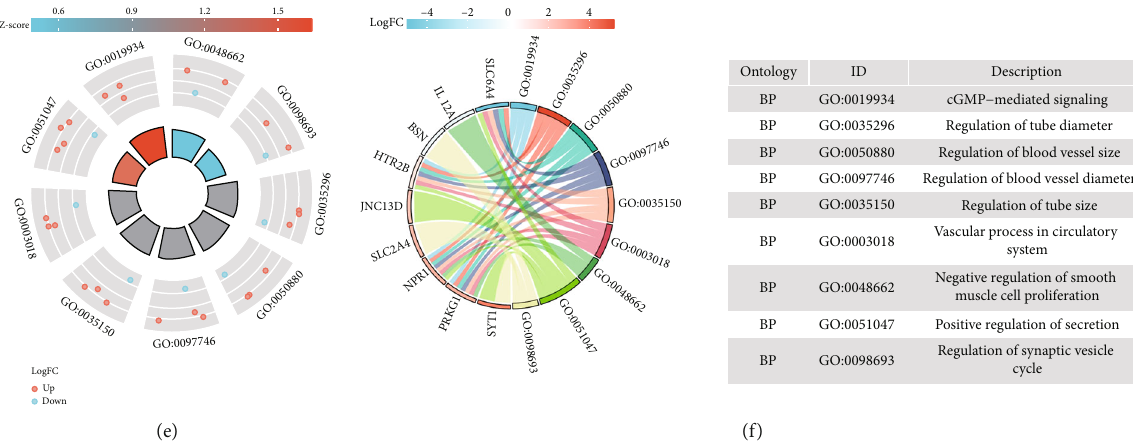
Figure 3: GO enrichment analyses of DEGs. (a) Biological process enrichment by GO analysis. (b) Cellular component enrichment by GO analysis. (c) Molecular function enrichment by GO analysis. (d – f) GO enrichment